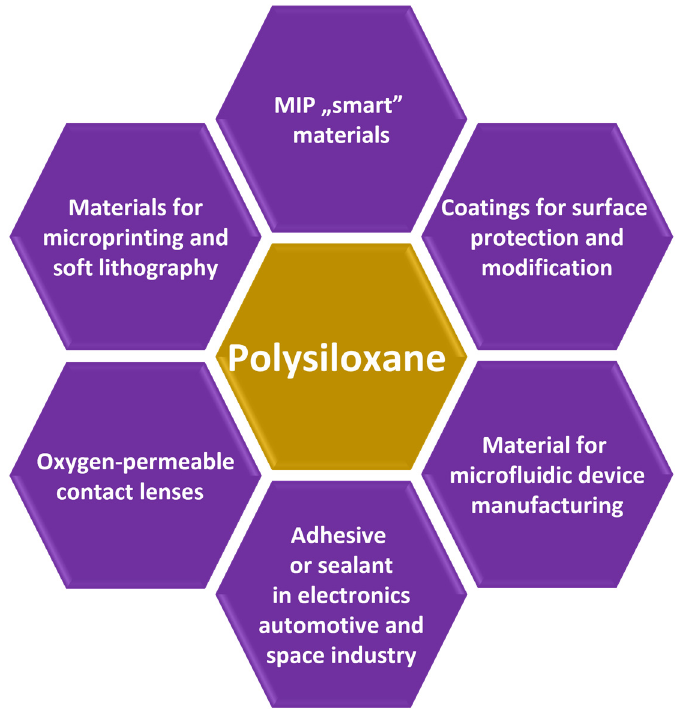
Figure 1. Application areas of polysiloxanes.